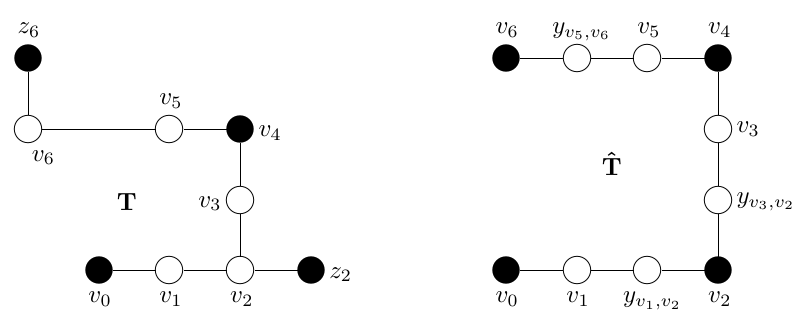
Fig. 10: An example for the construction of ˆ T from a backbone tree T